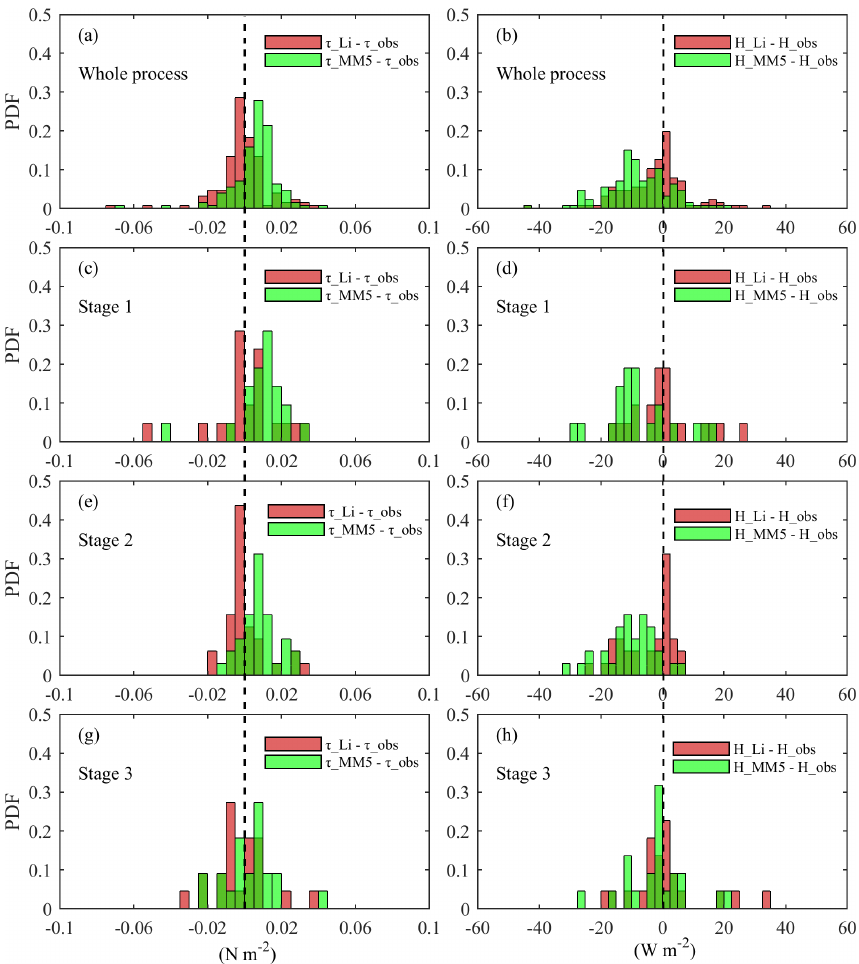
Figure 8. Probability distribution functions (PDFs) of the differences between calculated fluxes (momentum fluxes: left; sensible heat fluxes: right) using two schemes (the Li scheme: red bars; the MM5 scheme: green bars) and for observations in different stages ( a, b : whole process; c, d : stage 1; e, f : stage 2; g, h : stage